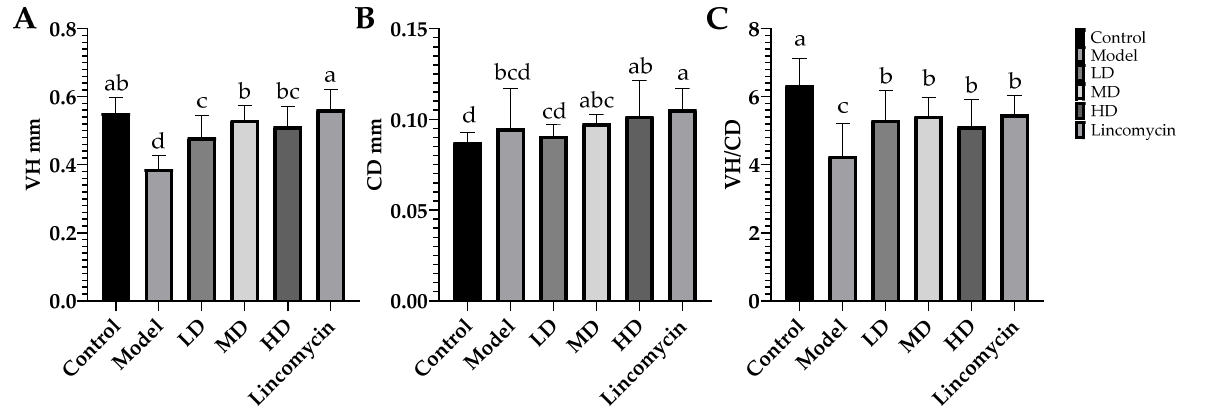
Figure 5. Jejunal morphological metrics. ( A ) Jejunal villus height (VH); ( B ) jejunal crypt depth (CD); ( C ) villus height/crypt depth (V/C). Values with the same superscript letters in the same line were not significantly different ( p > 0.05); values with different letters were significantly different ( p < 0.05).